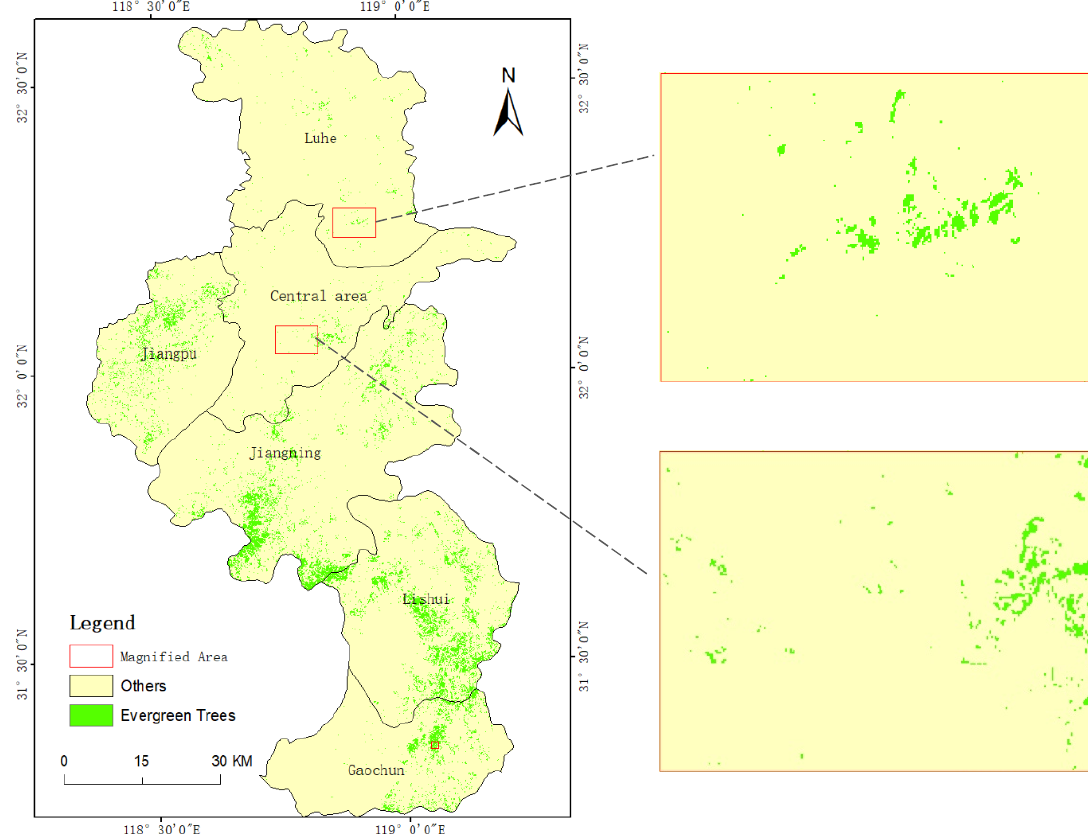
Figure 6. Spatial distribution of evergreen trees in Nanjing.